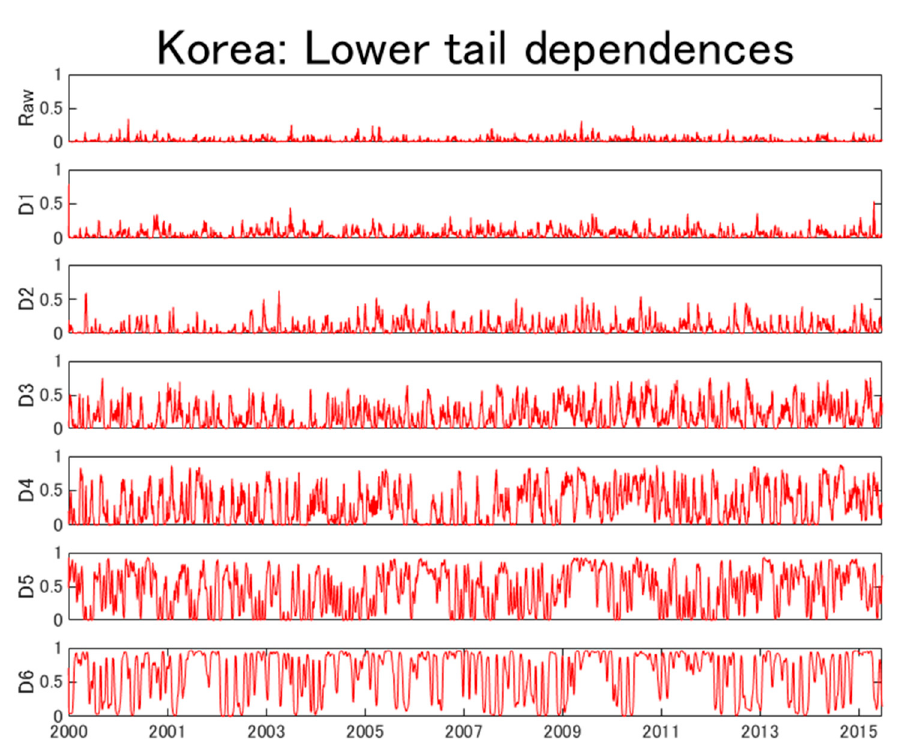
Figure 3. Time-varying tail dependence between crude oil and East Asian stock markets from SJC copula estimates.